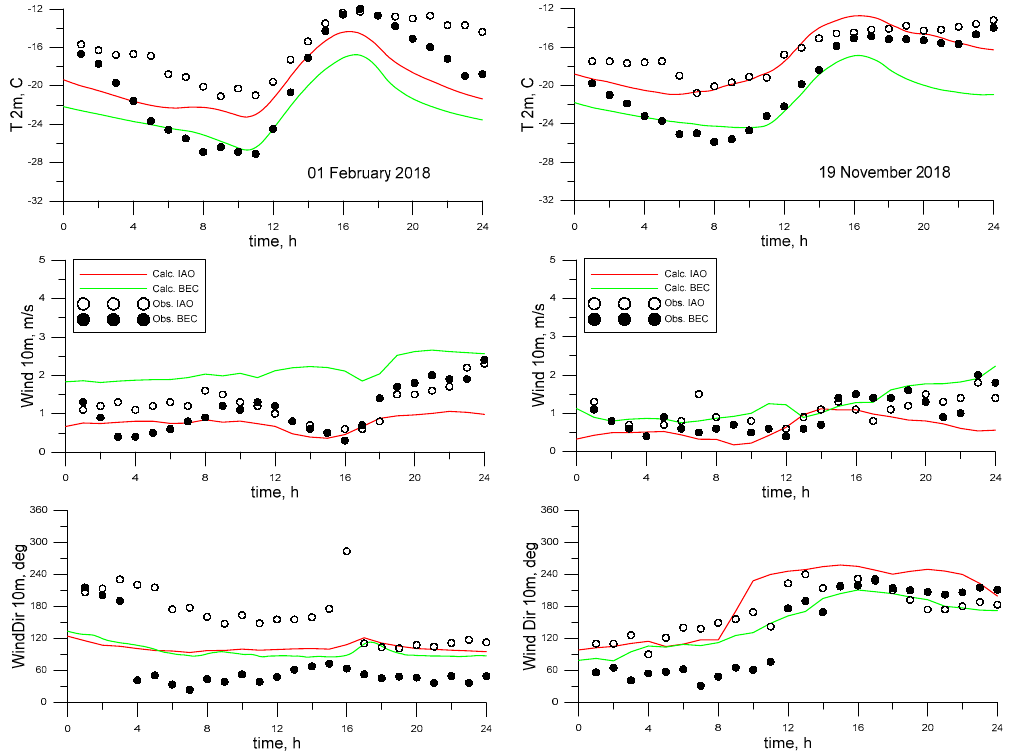
Figure 4. Numerical and experimental values of 2 m temperature, 10 m wind speed, and direction for 1 February 2018 (left) and 19 November 2018 (right). Lines indicate the results of numerical predictions (red—IAO station, green—BEC station), and circles indicate observation data (open circles—IAO, closed circles—BEC).